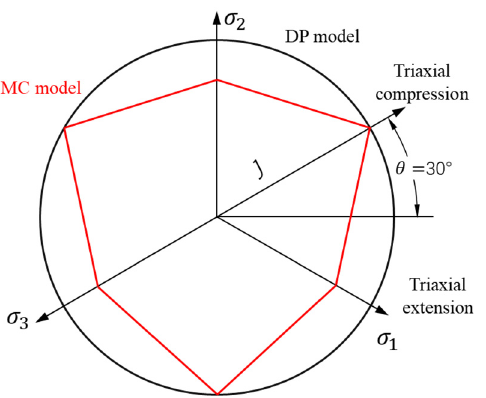
is determined as shown below: